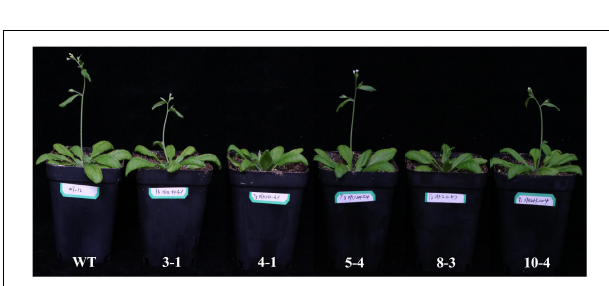
FIGURE 5 | The flowering time in 1-month-old wild-type and GrTCP11 -overexpressed transgenic lines (3-1, 4-1, 5-4, 8-3, and